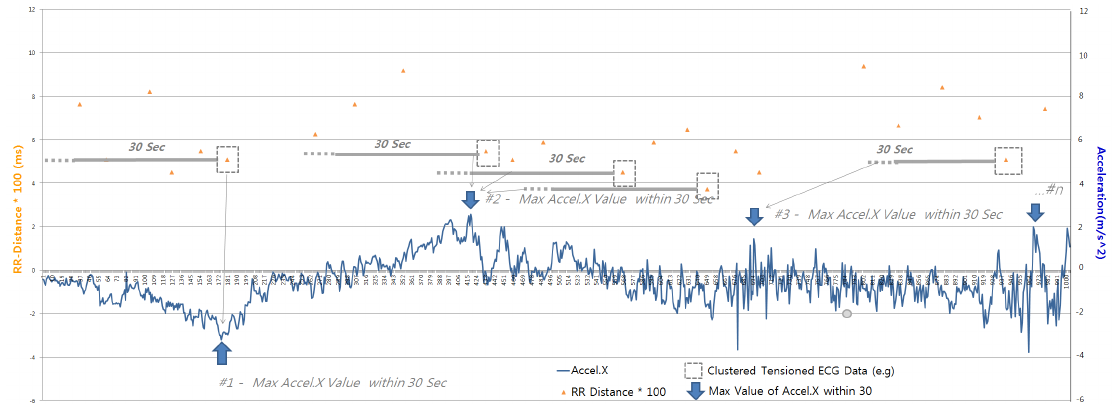
Figure 4. #n points of maximum acceleration within MTW (30 s, Maximum Time Window). These moments were considered to be most stressful driving moment, which cause heart